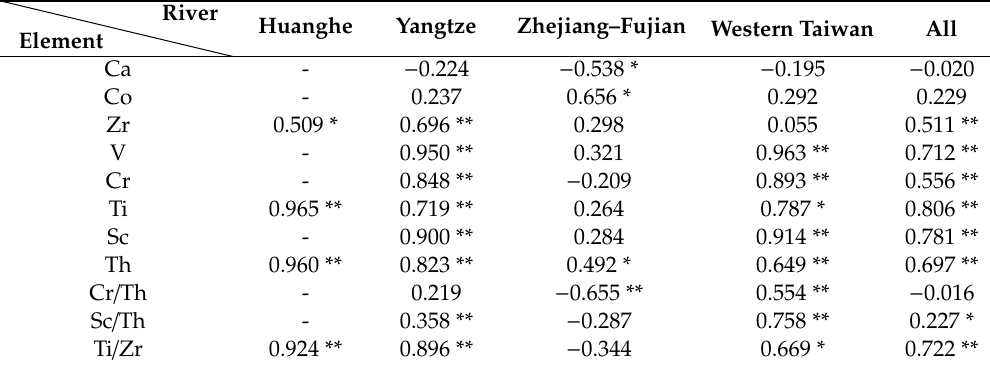
Correlation between the elements and Al (grain size) in the residual phase of the riverine